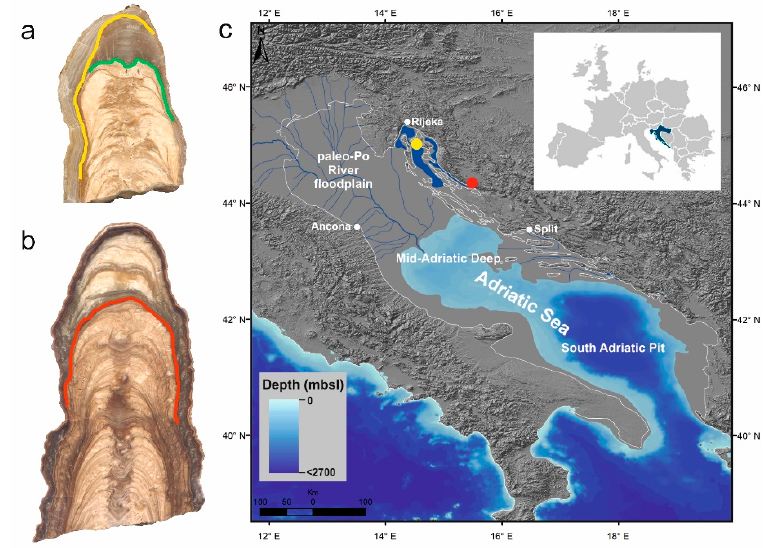
Figure 6. Longitudinal section of submerged speleothems ( a ) K-18 and ( b ) K-14 from U Vode Pit (Krk Island) with marked hiatuses caused by sea transgression [101] during 77–64 ka (yellow), 90–82 ka (green) and 87–82 ka (red). ( c ) Palaeogeography of the study area during the LGM (modified after [54], with the present coastline given in white. Note the distance of the MP cave (red dot) and Krk Island area (yellow dot) from the then coastline. ( Reprinted from Paleogeography, Palaeoclimatology, Palaeoecology, 544, Brunovi ć , D., Miko, S., Hasan, O., Papatheodorou, G., Ilijani ć , N., Miserocchi, S., Correggiari, A., Geraga, M.: Late Pleistocene and Holocene paleoenvironmental reconstruction of a drowned karst isolation basin (Lošinj Channel, NE Adriatic Sea), 109587, Copyright (2020), with permission from Elsevier. )